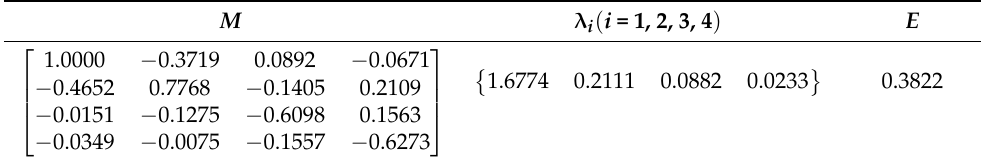
Table 1. The decomposition results.